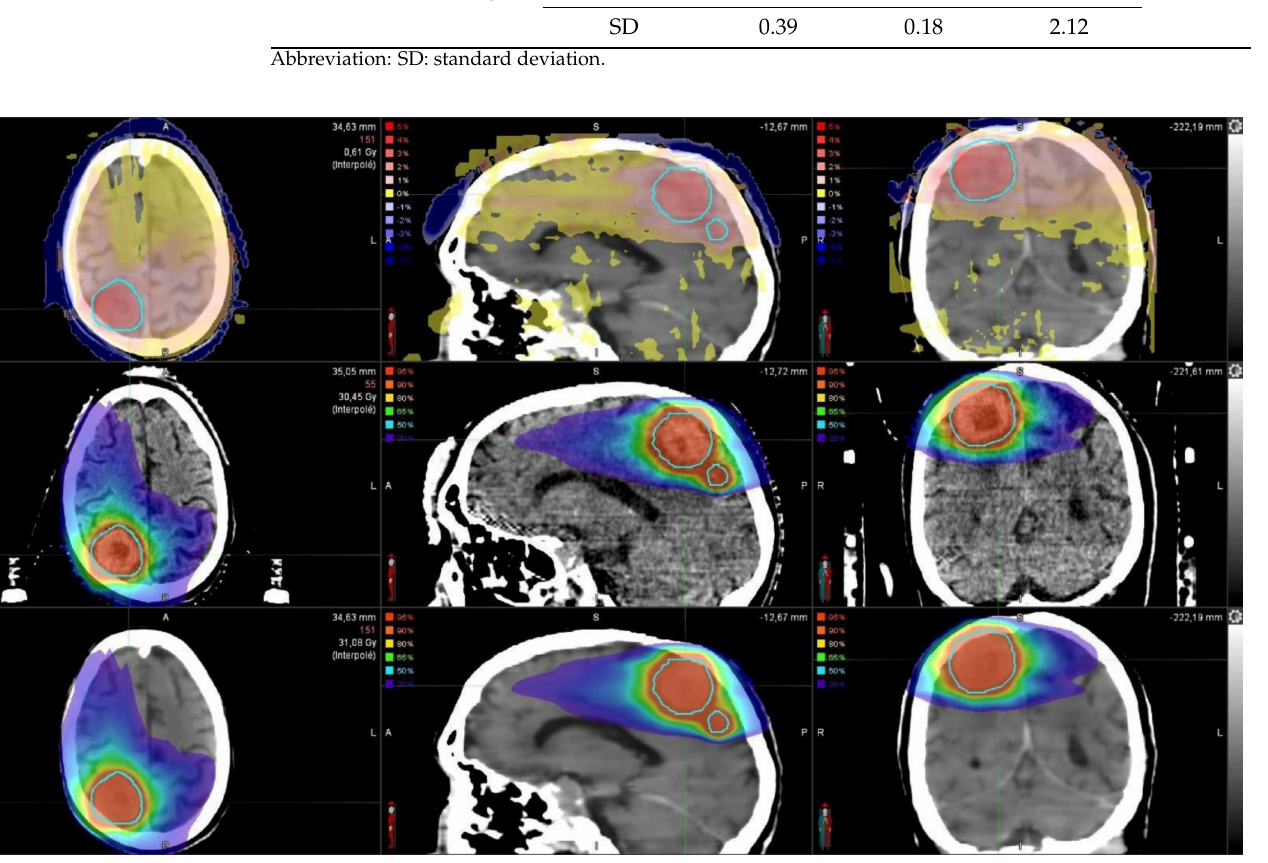
Figure 1. Dose comparison between the initial dose map ( middle ) and the synthetic dose map ( bottom ). Gamma analysis between both dose maps ( top ). PTVs ( n = 2) are highlighted in light